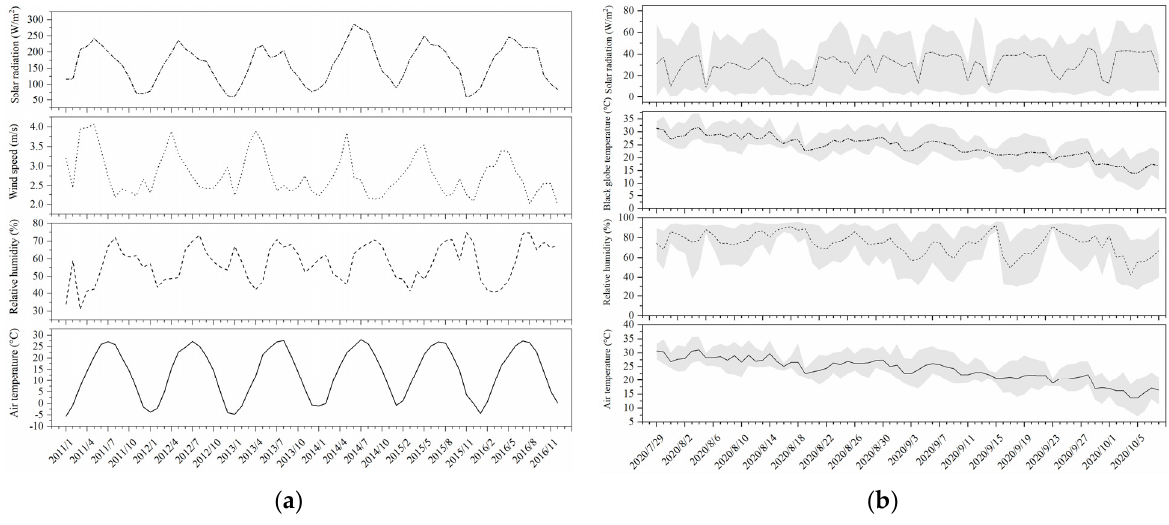
Figure 1. ( a ) Monthly variations in the average values of the outdoor environmental factors of the measured region (2011–2016) and ( b ) daily variations in the average values of the environmental factors inside the barns over the study period. The black line indicates the average value. The grey region indicates the maximum and minimum values.